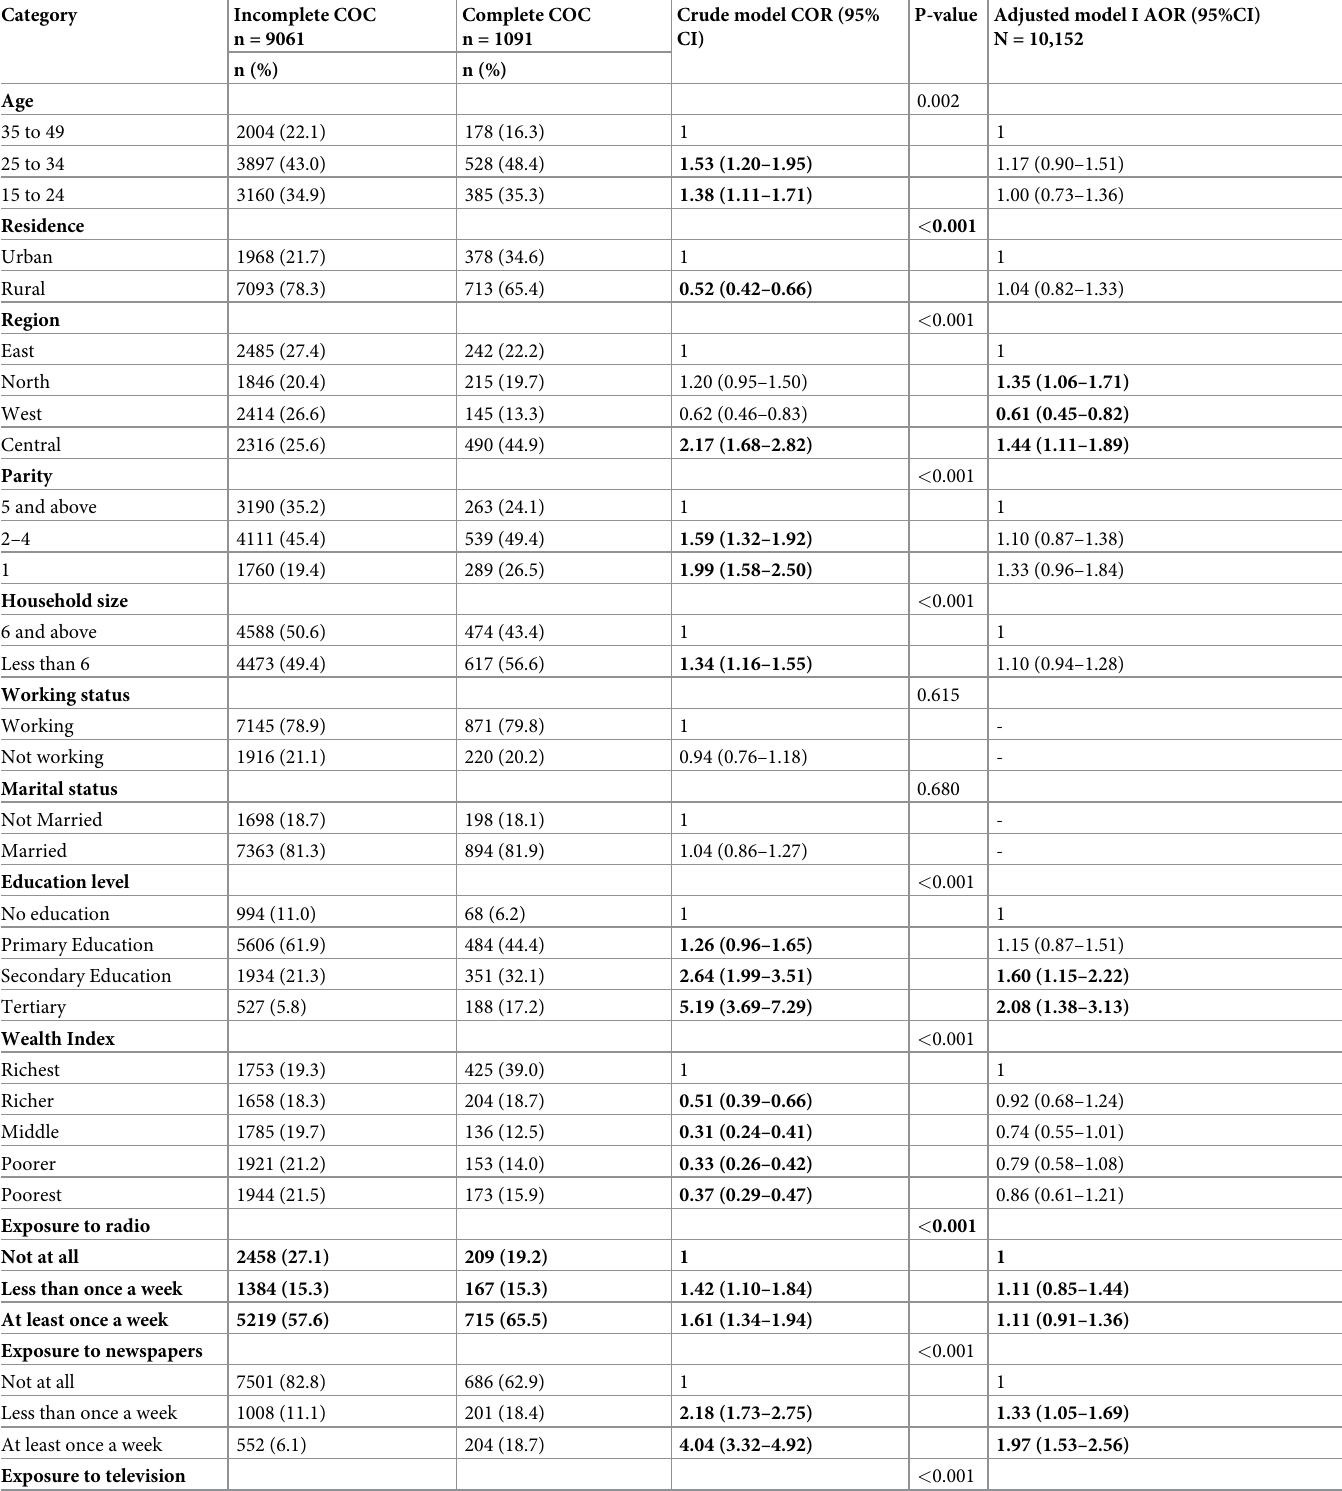
Table 3. Predictors of complete continuum of maternal care in